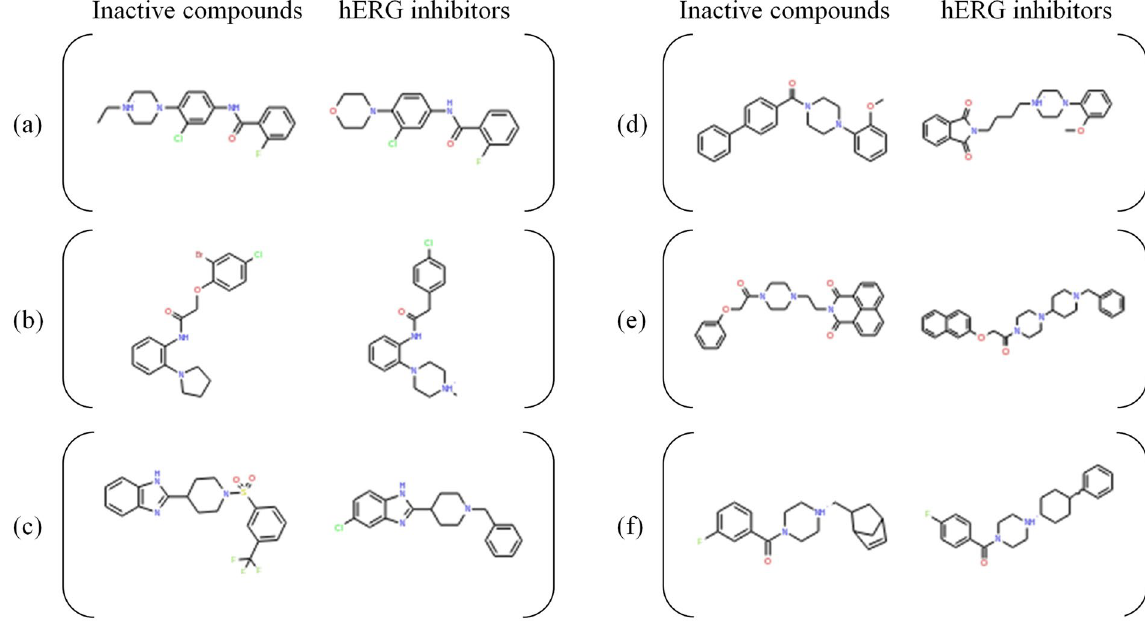
Figure 5. Compounds for which only the SVM model correctly predicted the activities, and their most similar hERG inhibitors. Each structure was ionized at